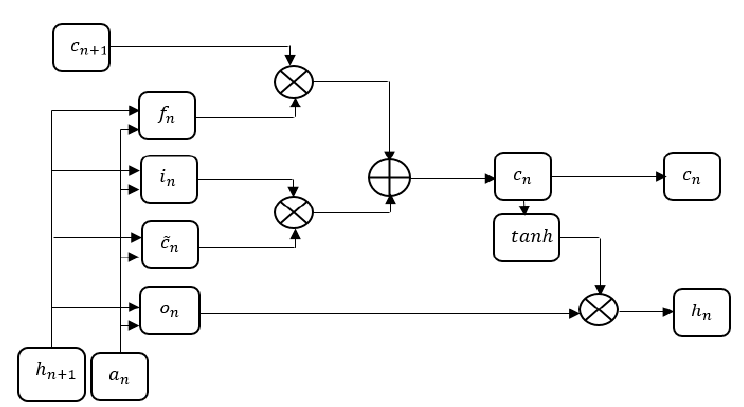
Figure 7. Graphical representation of the single LSTM unit.